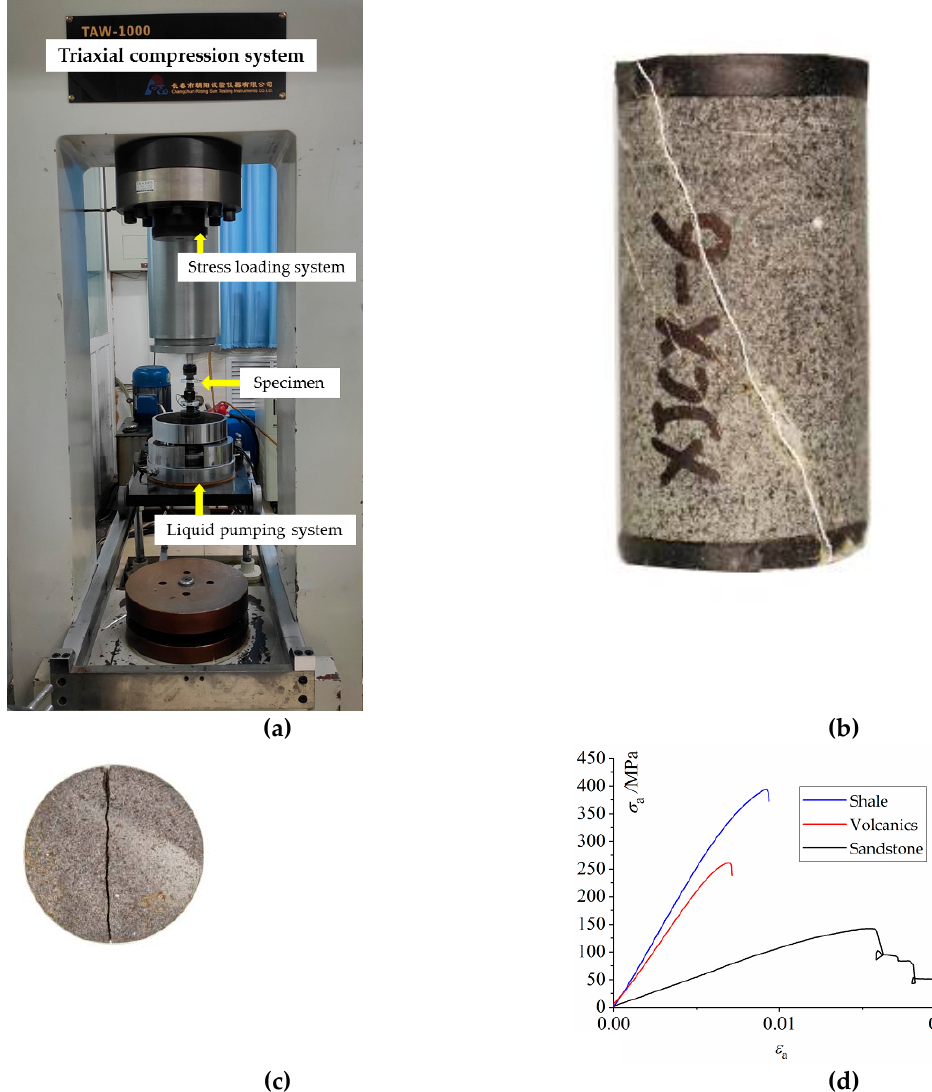
Figure 3. ( a ) Triaxial compression experimental setup; ( b ) a sample from the triaxial compression test; ( c ) a sample from Brazilian splitting test; and ( d ) a triaxial compression test performance of three different rock specimens.